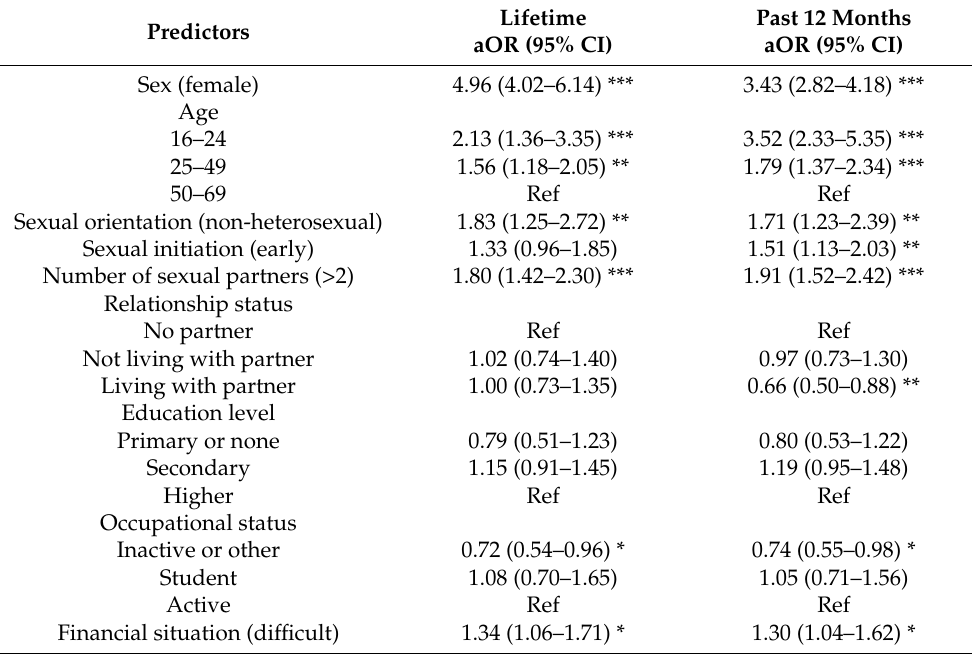
Table 7. Logistic regression analysis of factors associated with sexual